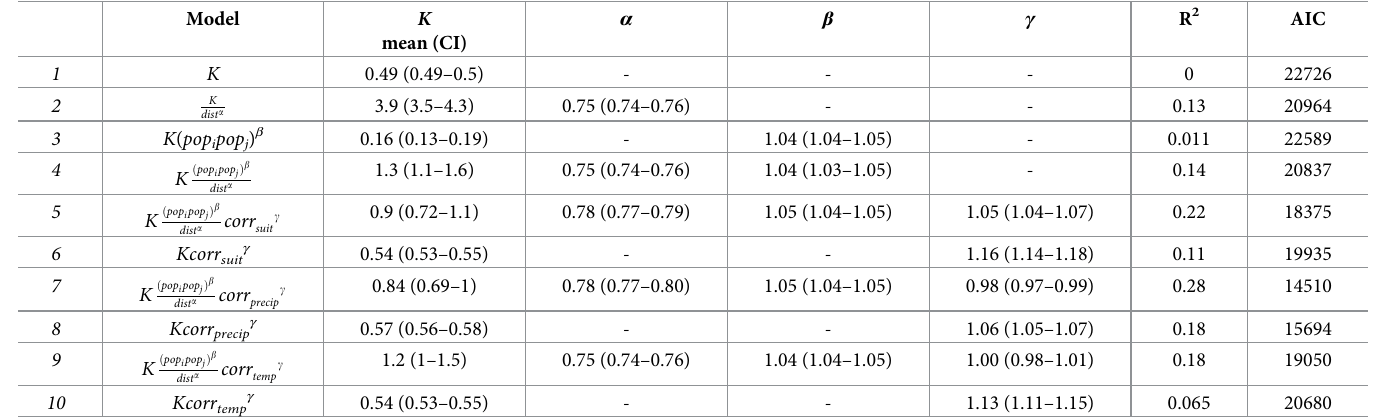
Table 2. Gravity style model fitting for annual phase angle correlation between Urban-2 regions.